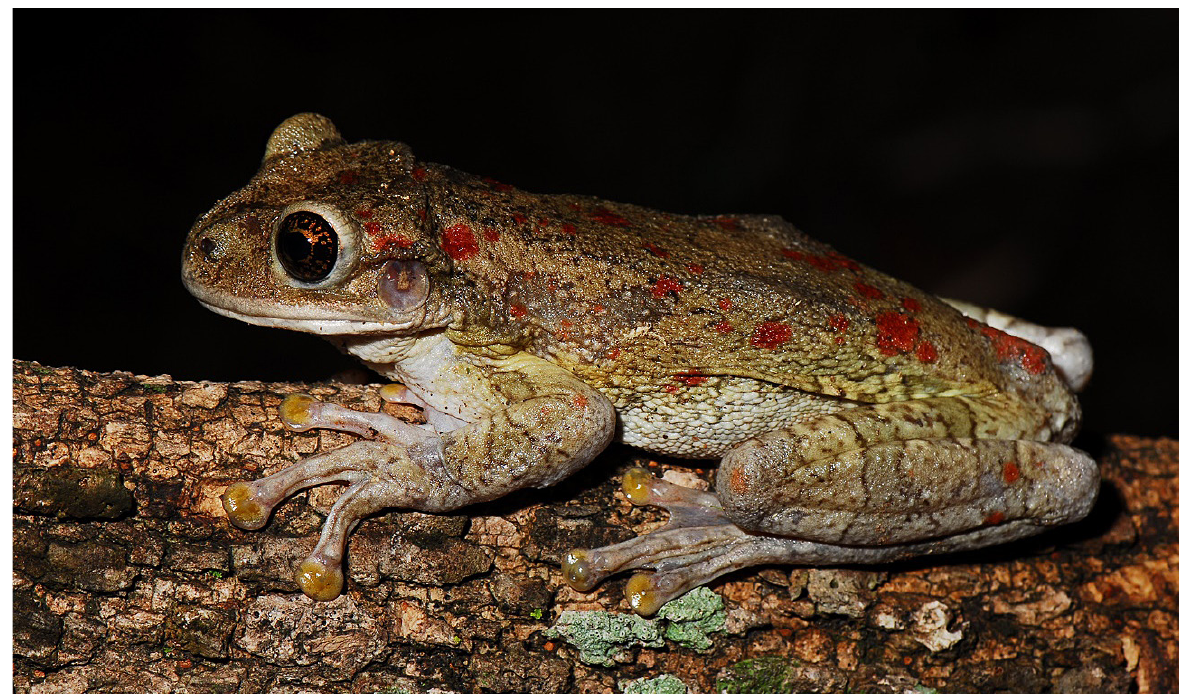
Figure 1. Adult Trachycephalus nigromaculatus (MNRJ 87636) from the municipality of Riacho Frio, Piauí, Brazil. Photo by R.A.